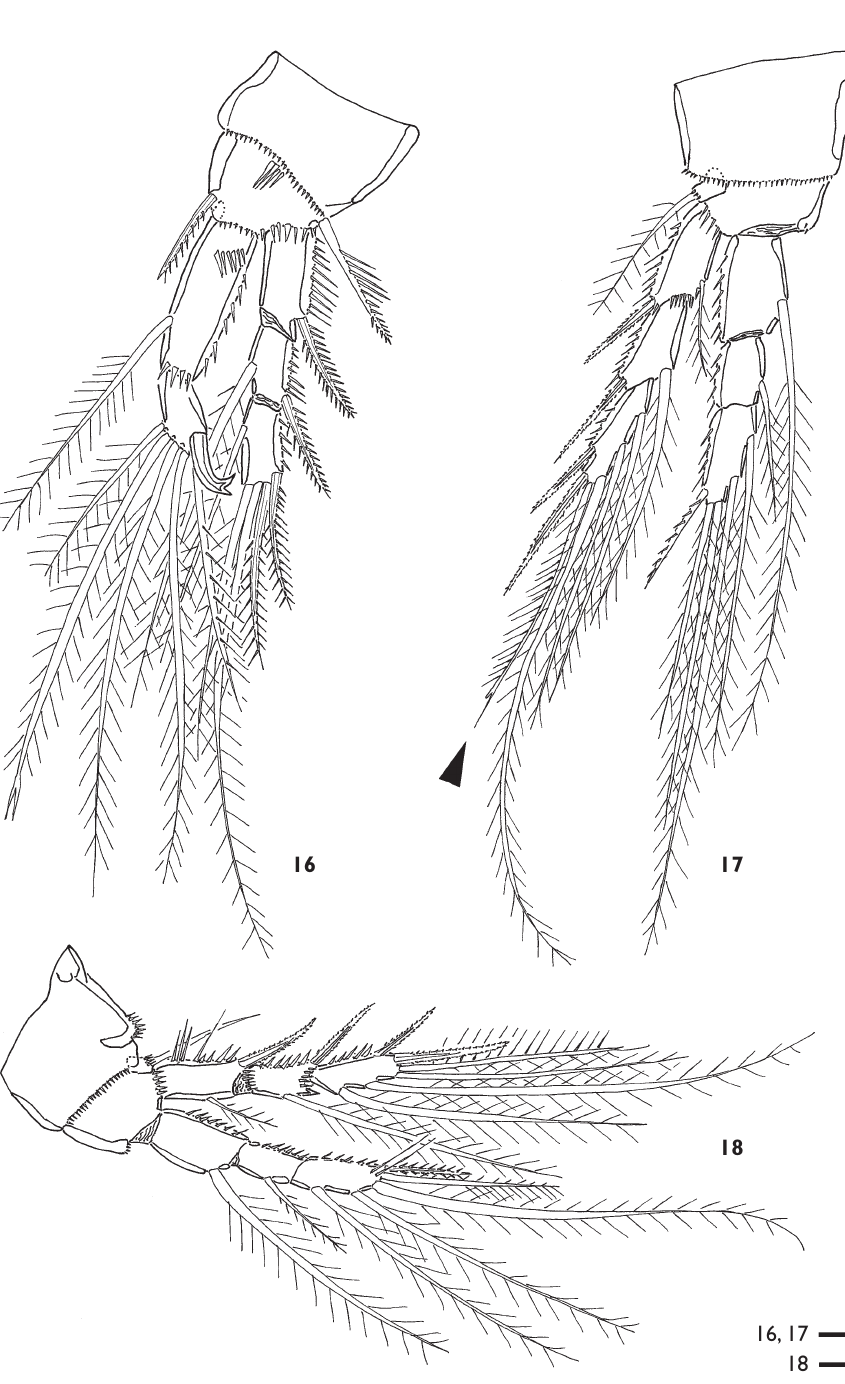
Figures 16-18. Chaulionyx paivacarvalhoi gen. et sp. n. ♀ : 16 P1, anterior; 17 P2, anterior [seta with apical fl agellum arrowed] 18 P3, anterior. Scale bars = 10